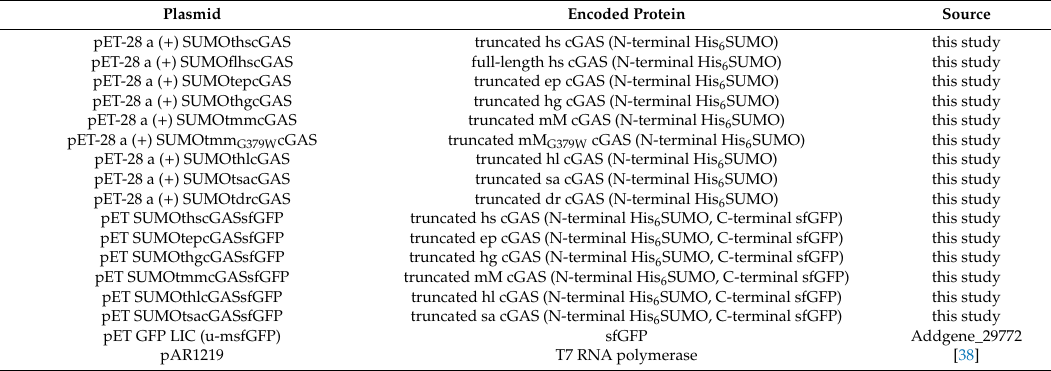
Table 1. Plasmids used in this